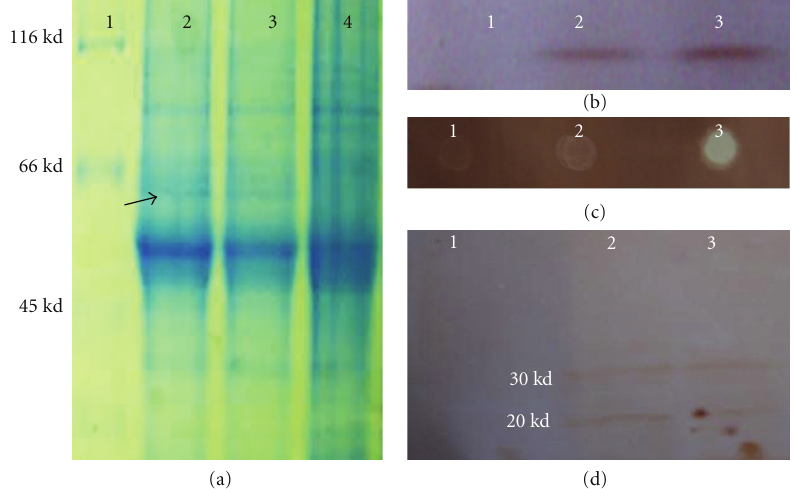
Figure 5: Analysis of expression of the human FVII by SDS-PAGE and western blotting and detection of purified rFVII by dot blot and western blot. (a) FVII protein band on 12% SDS-PAGE from transfected (Lanes 2, 3) and untransfected I.L.L. as a negative control (Lane 4). (b). expressed FVII protein band in transfected I.L.L. (Lane 2) and negative control untransfected cells (Lane 1), commercially available rFVII as a positive control (Lane 3). (c) Positive control sample rFVIIa (Lane 1), purified rFVII appears as a brown colored spot (Lane 2), purified product of negative control untransfected cells. (d) the purified rFVII from transfected I.L.L (Lane 2, 3) was analyzed by western blot. Two chains of activated form of rFVII with corresponding length are shown; Lane 1, untransfected I.L.L.